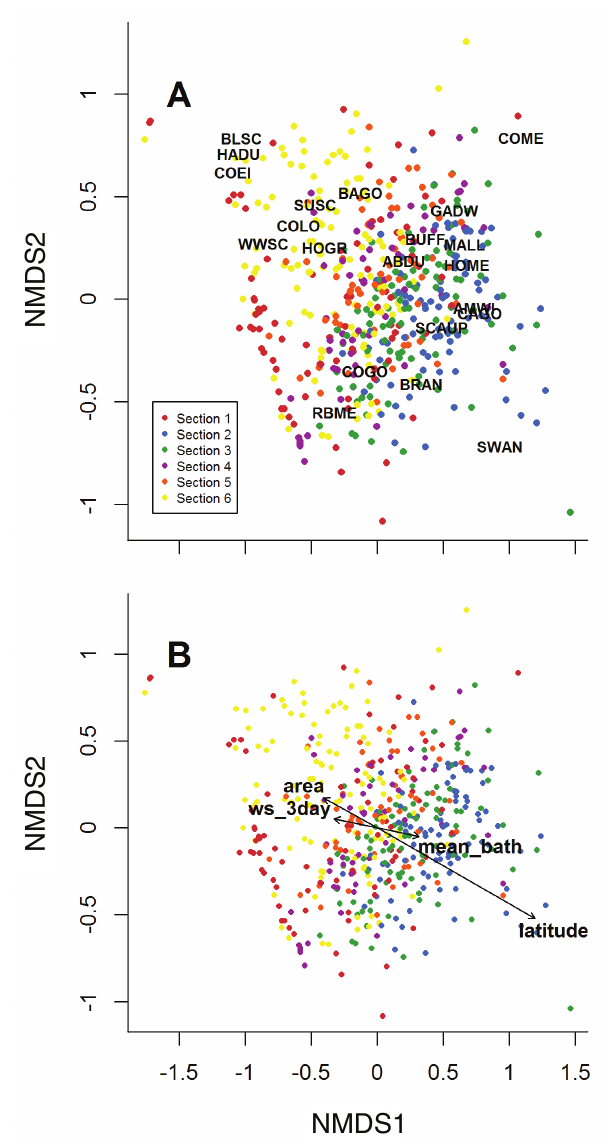
Figure 4. Final NMDS results. The circles illustrate the location of a single site for each surveyed year. The sites are color-coded by section. Figure 4A: Species locations are illustrated with four- letter abbreviation. Long-tailed duck and king eider were rare and therefore plotted a considerable distance from all other species. To increase the legibility of this figure, we zoomed in on the main cluster. However, long-tailed was 0.09 on NMDS 1 and -1.54 on NMDS 2, and king eider was -1.041 and -1.45. Figure 4B: Bi-plot of NMDS axis one and two with vectors of significant environmental variables overlaid. The arrow’s direction illustrates the environmental gradient and the length is proportional to the correlation strength between the variable and the NMDS (See Table 3).